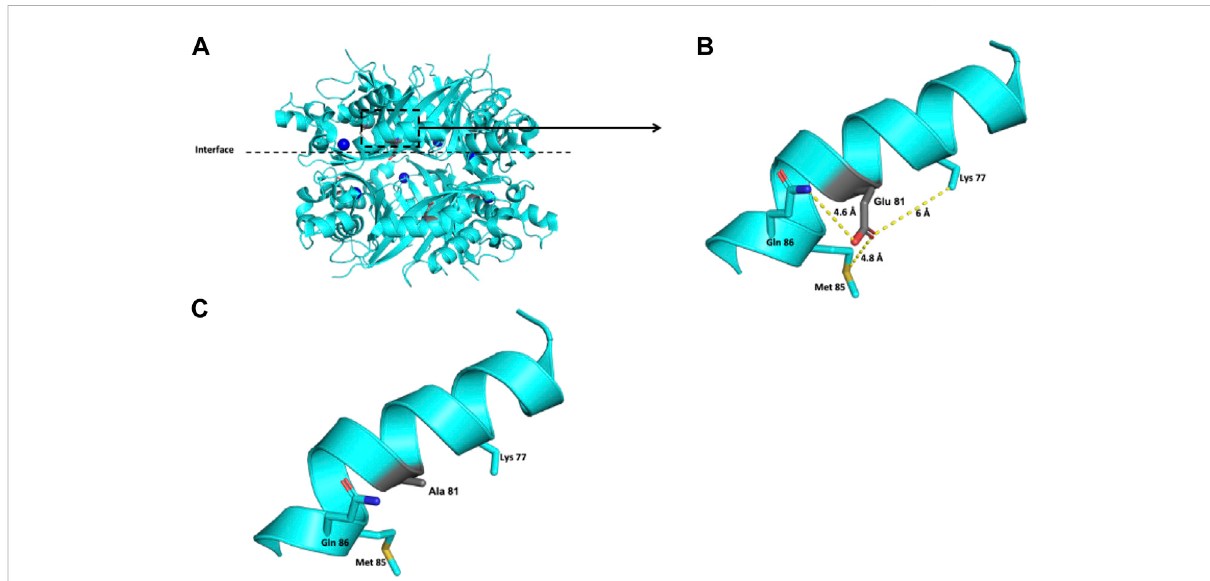
FIGURE 3 Modeling of the human PTPS structure with p.(Glu81Ala) change. (A) Crystallographic structure of a trimer of PTPS and location of the Glu 81 residues on each monomer. (B) Location of the Glu 81 residue in one monomer. (C) Potential pathogenic effect for the substitution of Glu by Ala.